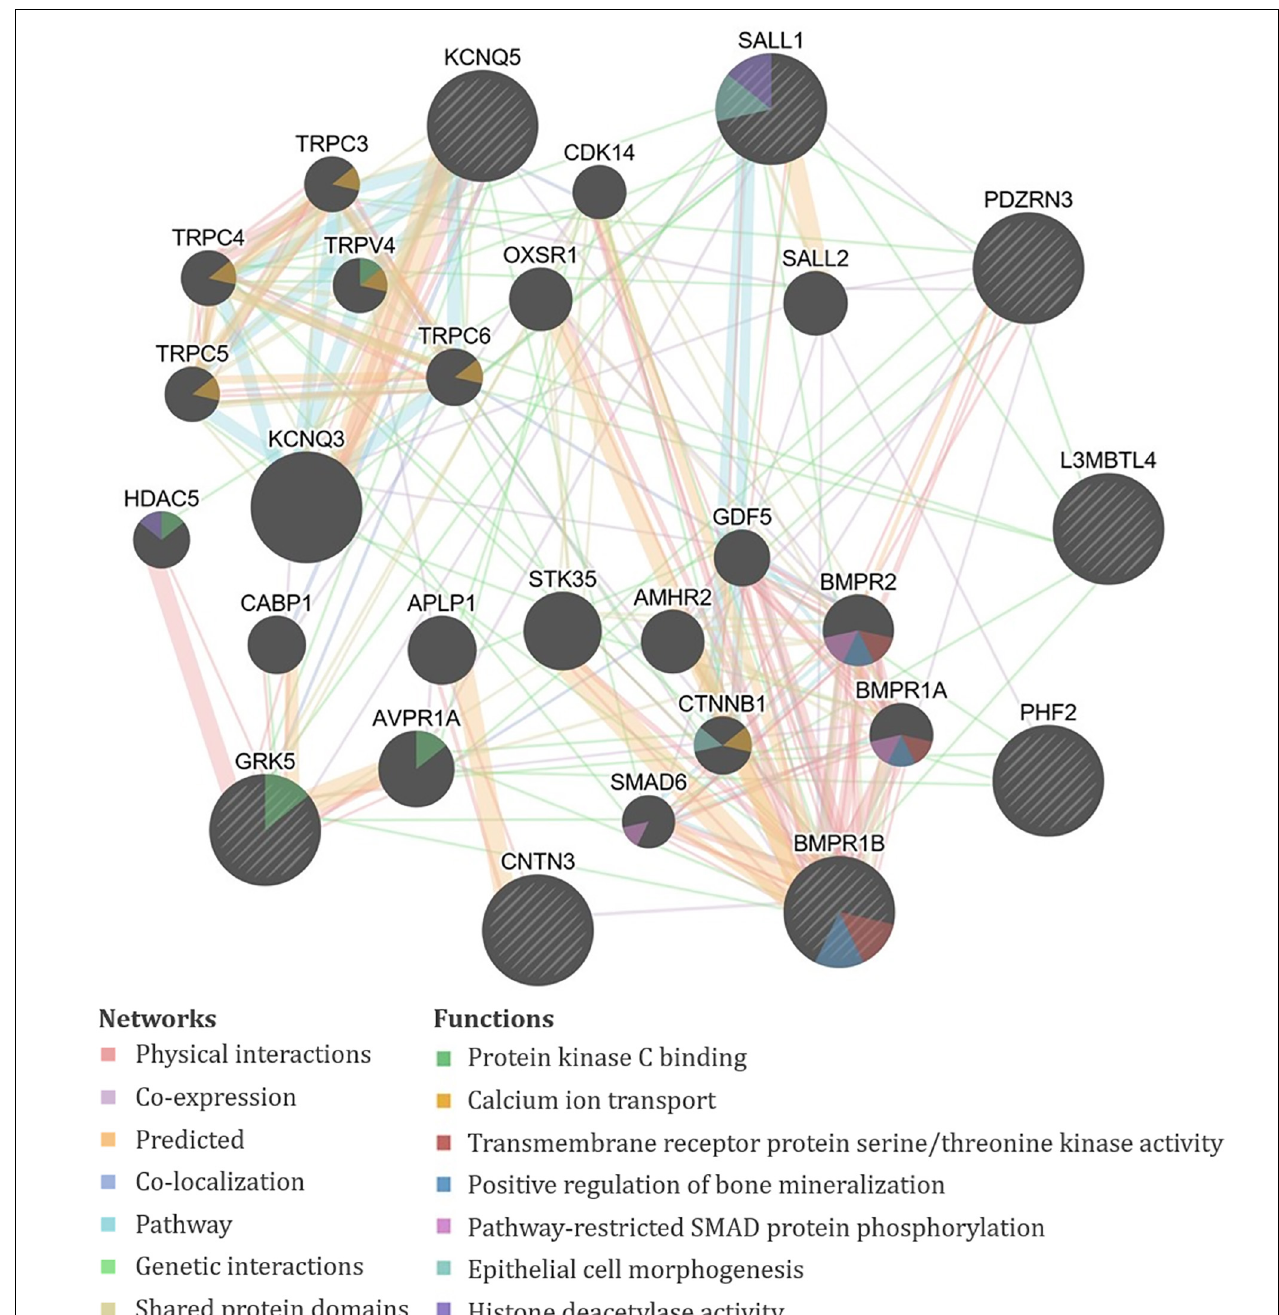
FIGURE 4 | GeneMANIA output for the products of genes proximal to the significant single-nucleotide polymorphisms (SNPs) associated with exposure-adjusted trisaminohexyl isocyanurate (TAHI) levels in urine. Query genes have black circles with white-striped lines, the networks are shown with the colored lines between genes, and the shading on the circles shows the